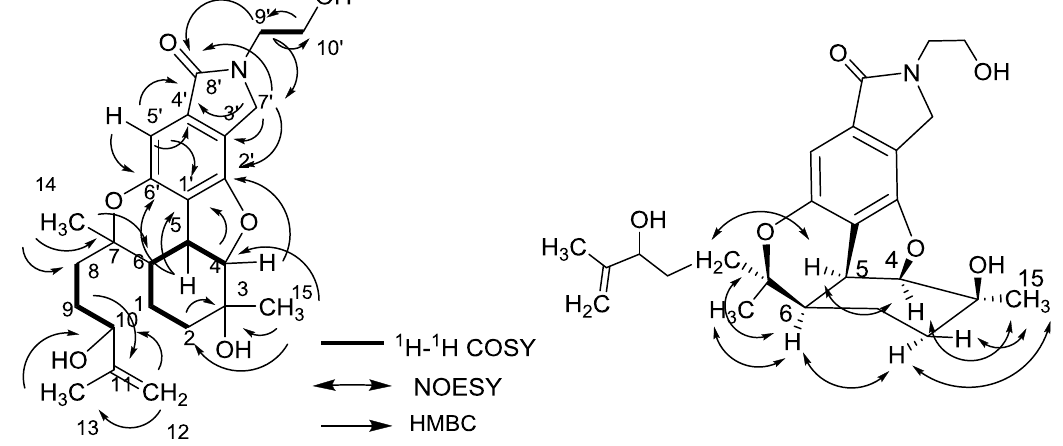
Figure 4. COSY, HMBC and NOESY correlations of compound 2